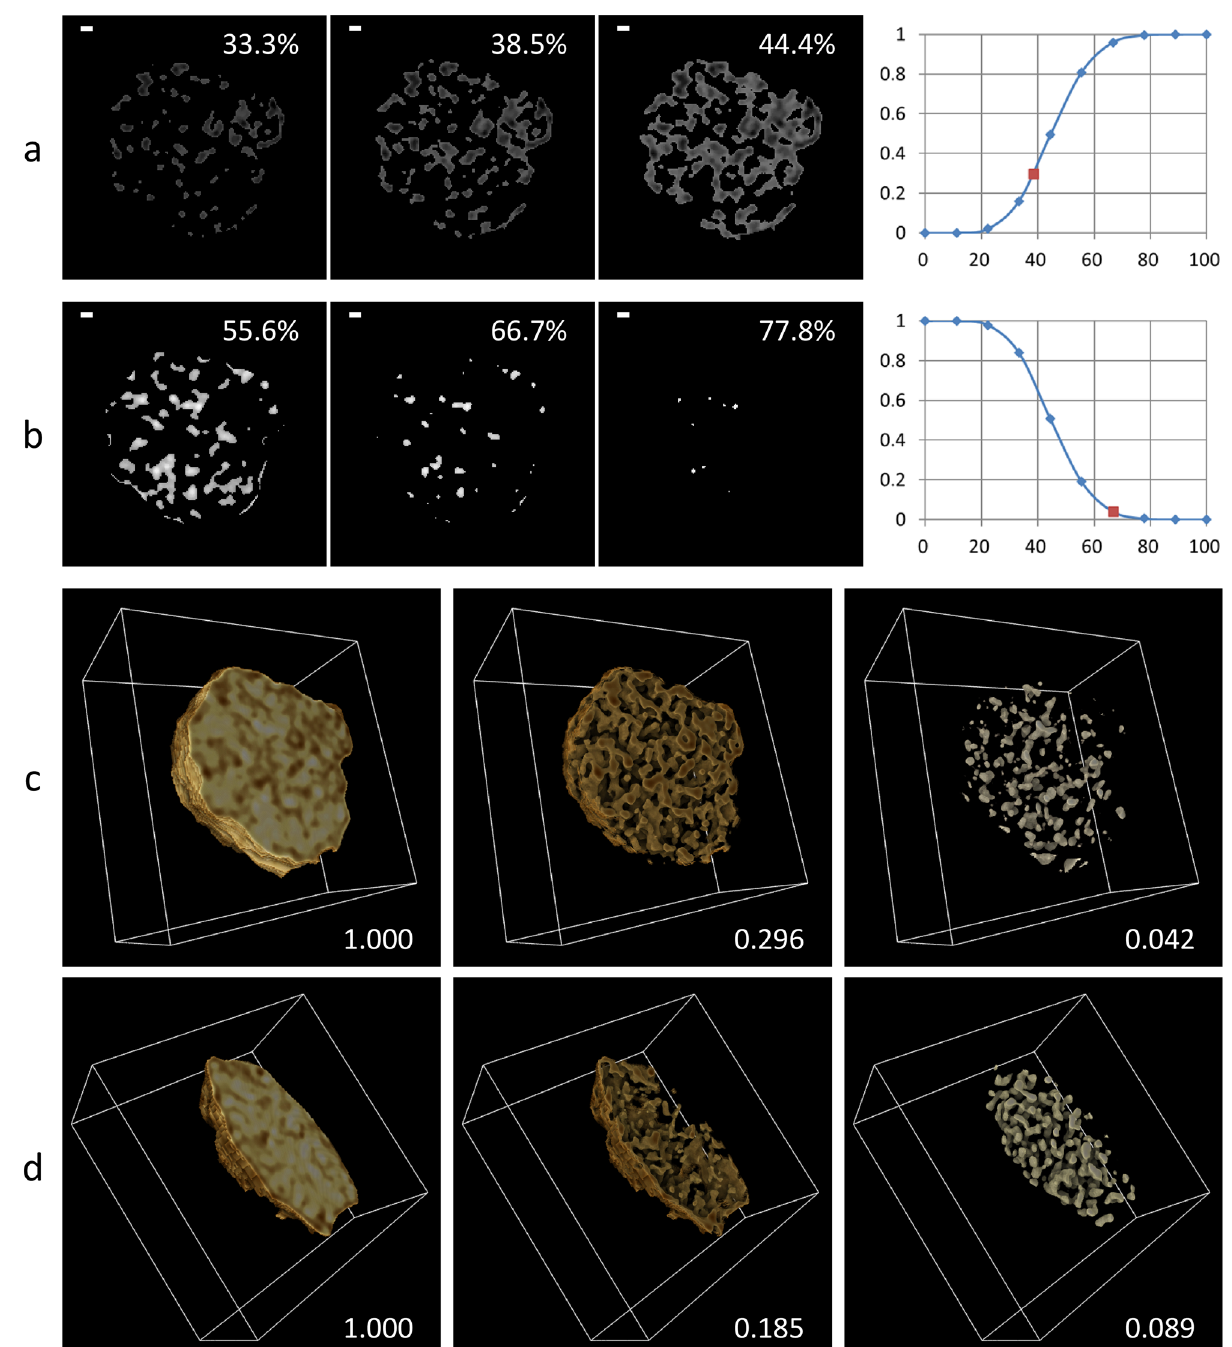
Figure 5. Volumetric analysis of glomerulus. This figure corresponds to Table 2. ( a , b ) Preliminary analysis using a CT slice with segmented regions of a glomerulus from normal mouse. Scale bars: 5 μm. The glomerulus regions were subdivided into ( a ) low-density regions including putative vessels and ( b ) high-density regions including putative nuclei, based on a relative threshold (RT) value indicated (left three panels), using the program ImageJ 33 . See Methods for the definition of RT value. Ratio of selected voxels was plotted versus RT (right panel). Determined suitable RT values for the subregions are indicated by red squares: 38.5% for the low- density regions and 66.7% for the high-density regions. 3D rendering of subdivided glomerulus from ( c ) normal mouse and from ( d ) disease model mouse. The subdivided CT slices were reconstructed using the program Drishti 34 . Original CT image (left), subdivided low-density regions (center), and subdivided high-density regions (right) are shown with calculated ratio of non-zero volume. Color code used was a linear gradient from brown to white indicating the lowest and the highest opacities, respectively. Box size: (107 × 107 × 56) μm 3 for ( c ) and (107 × 107 × 53) μm 3 for ( d